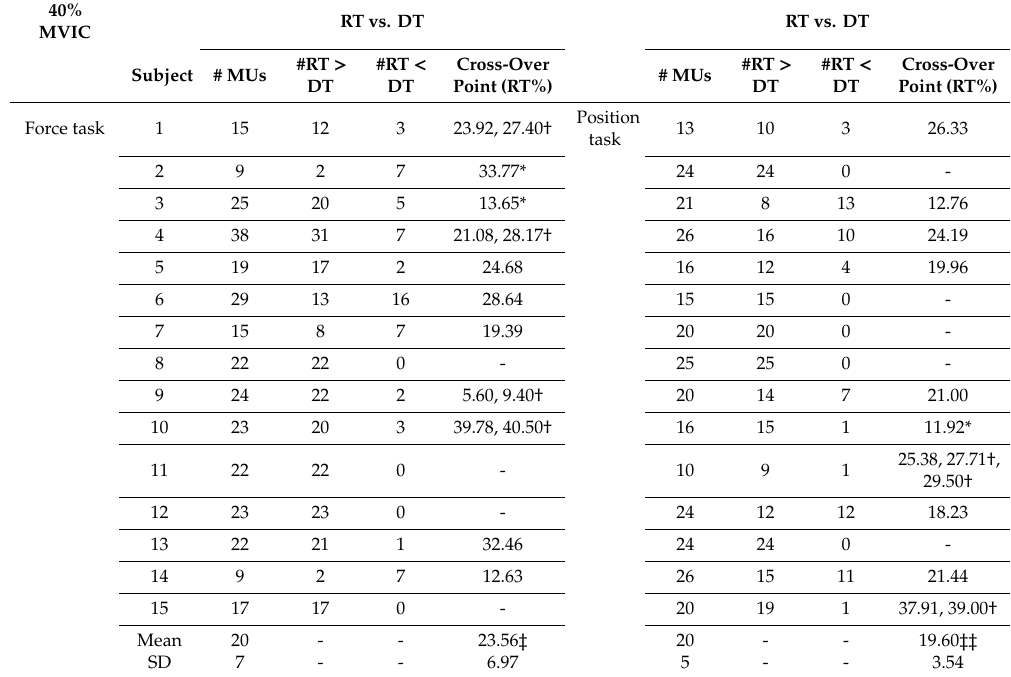
Figure 4. The theoretical regression lines obtained from the recruitment threshold (RT) versus the derecruitment threshold (DT) relationship for 15 subjects during the force task and position task at 40% and 70% maximal voluntary isometric contraction (MVIC). Table 1. The number of motor units, the number of motor units with recruitment threshold (RT) < derecruitment threshold (DT) and RT > DT, and cross-over point (RT%) of the motor unit RT and DT relationship for force and position tasks at 40% maximal voluntary isometric contraction (MVIC) contraction